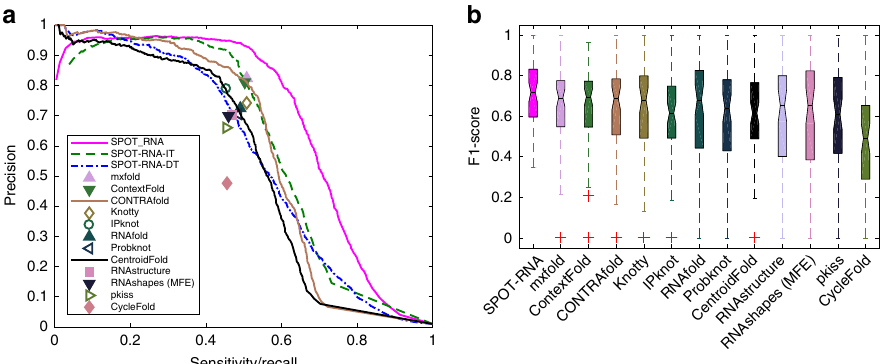
Fig. 2 Performance comparison of SPOT-RNA with 12 other predictors by using PR curve and boxplot on the test set TS1. a Precision-recall curves on the independent test set TS1 by initial training (SPOT-RNA-IT, the green dashed line), direct training (SPOT-RNA-DT, the blue dot-dashed line), and transfer learning (SPOT-RNA, the solid magenta line). Precision and sensitivity results from ten currently used predictors are also shown as labeled with open symbols for the methods accounting for pseudoknots and fi lled symbols for the methods not accounting for pseudoknots. CONTRAfold and CentroidFold were also shown as curves (Gold and Black) because their methods provide predicted probabilities. b Distribution of F1 score for individual RNAs on the independent test set TS1 given by various methods as labeled. On each box, the central mark indicates the median, and the bottom and top edges of the box indicate the 25th and 75th percentiles, respectively. The outliers are plotted individually by using the “ + ”